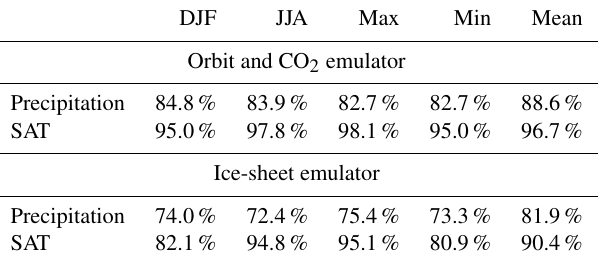
Table 4. Seasonal and annual mean emulator performance (as used in Sect. 7), measured by the metric P (Eq. 3, including 10 compo- nents). A power exponential covariance is used in all cases. Note that max and min values repeat data from Table